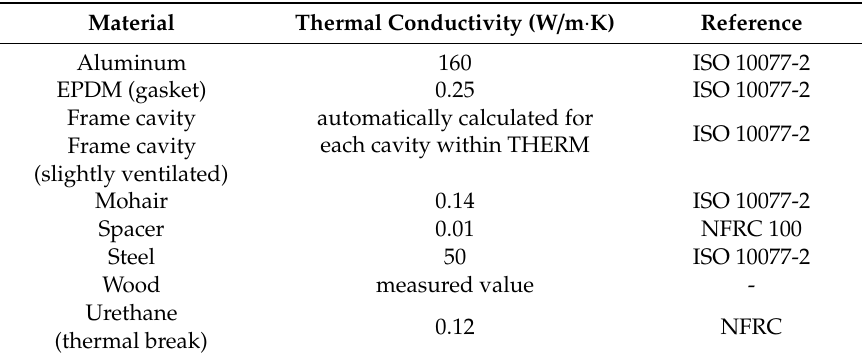
Table 3. Thermal properties of materials used in THERM.